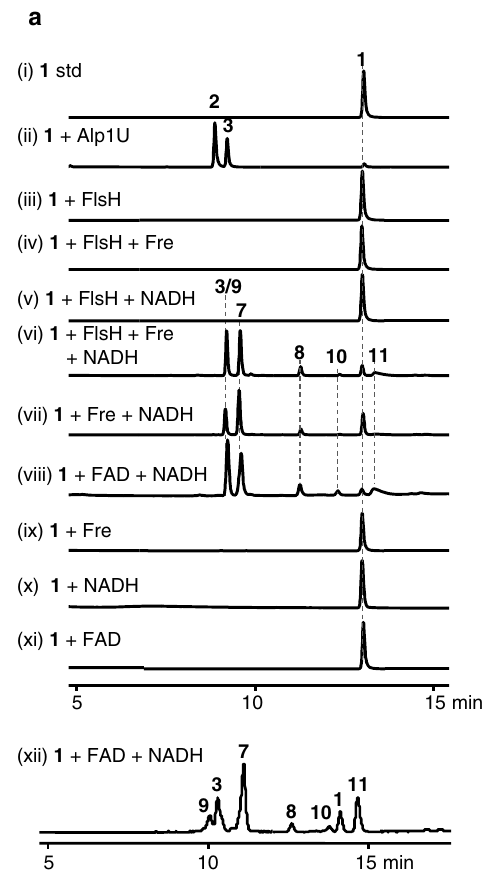
Fig. 2 | Epoxide ring opening reactions involving FST C (1). a HPLC analysis of reactions involving FST C ( 1 ). (i) 1 std.; (ii) 1 +Alp1U; (iii) 1 +FlsH; (iv) 1 +FlsH+Fre; (v) 1 +FlsH+NADH; (vi) 1 +FlsH+Fre+NADH; (vii) 1 +Fre+NADH; (viii) 1 +FAD+ NADH; (ix) 1 +Fre; (x) 1 +NADH; (xi) 1 +FAD; (xii) 1 +FAD+NADH. HPLC was per- formed using a reversed phase C18 column (i – xi) or in a polar column (xii). Reac- tions were run for 30min at 30°C in 50mM PBS buffer (pH 7.0) containing 5 μ M